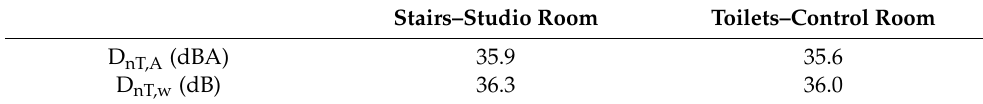
Figure 13. Standardized level difference from the initial measurement of the vertical partitions. Table 8. Weighted standardized level difference values of the vertical